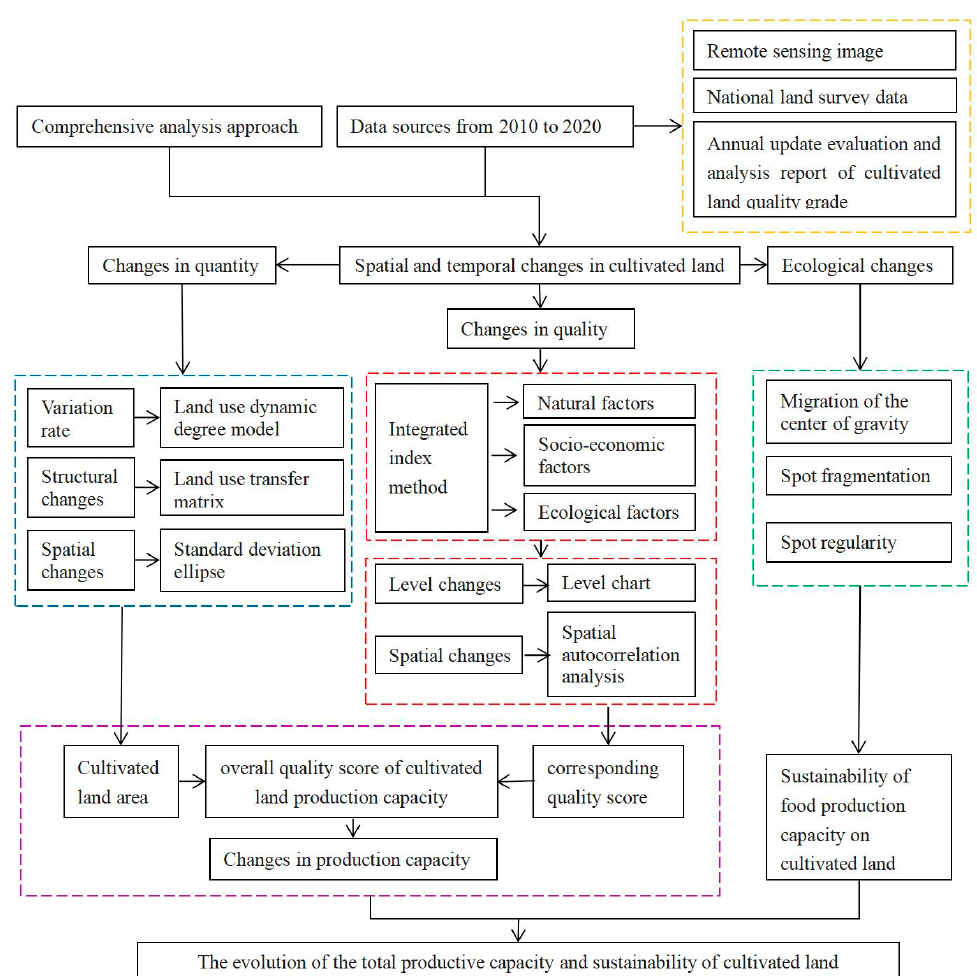
Figure 1. The research frame